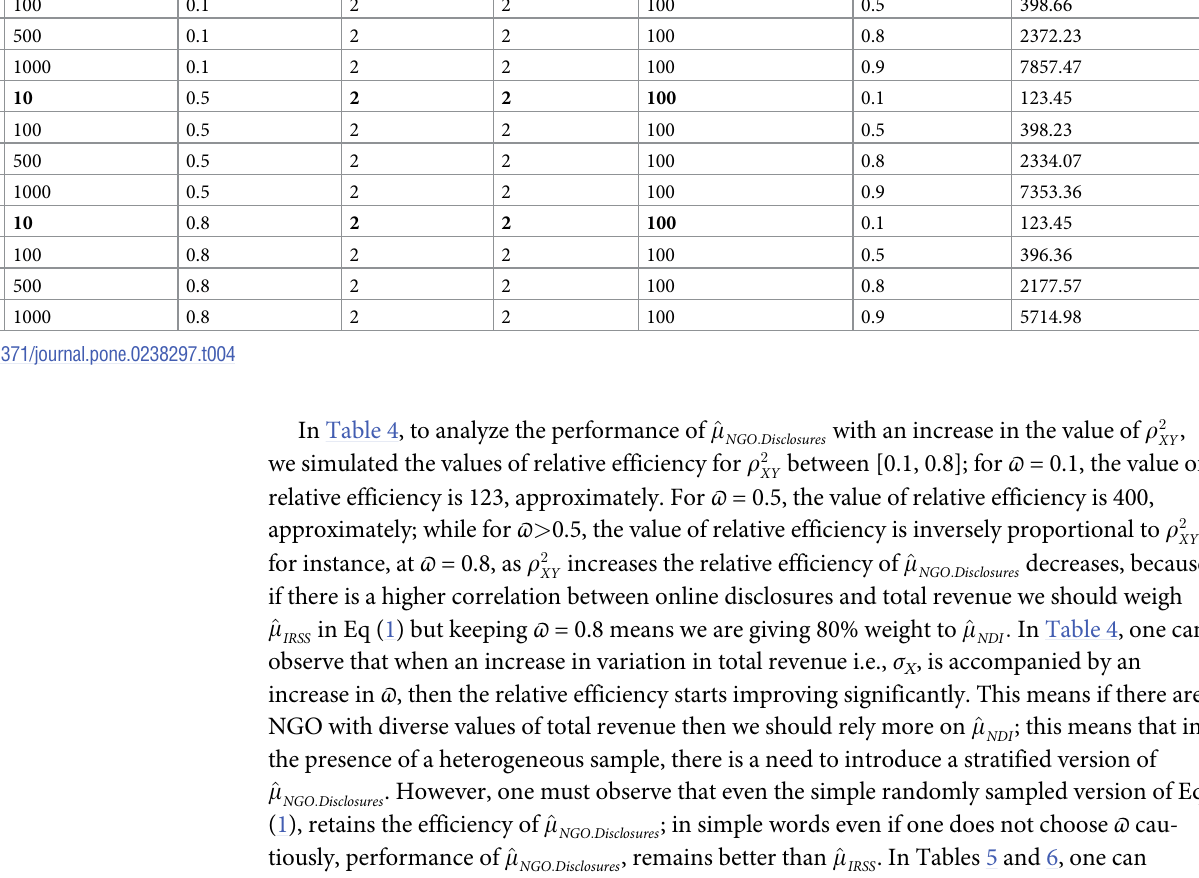
Table 5. Relative efficiency of ^ μ σ Y σ